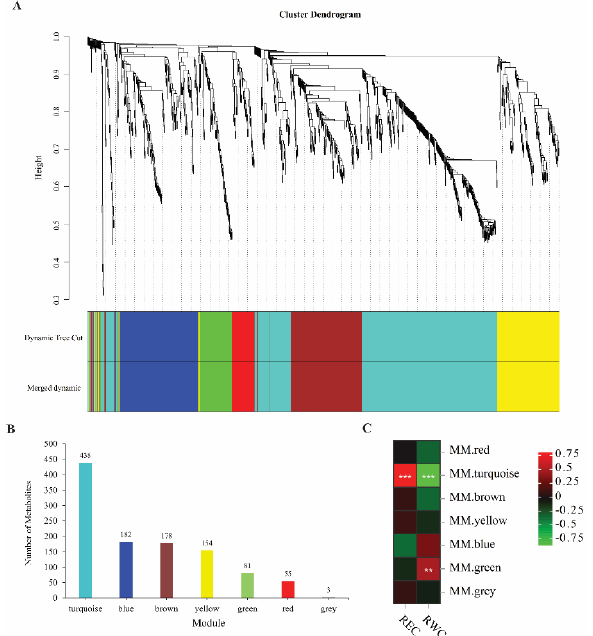
Figure 5. Graph of WGCNA results based on 1091 metabolites with REC and RWC, ( A ): Module Diagram of WGCNA, 7 different colors represent 7 different modules; ( B ): Histogram of the number of metabolites in each module; ( C ): Pearson’s correlation heatmap of 7 modules with REC and RWC, red is positive correlation, green is negative correlation, the darker the color, the stronger the correlation (*** means p < 0.001; ** means p <